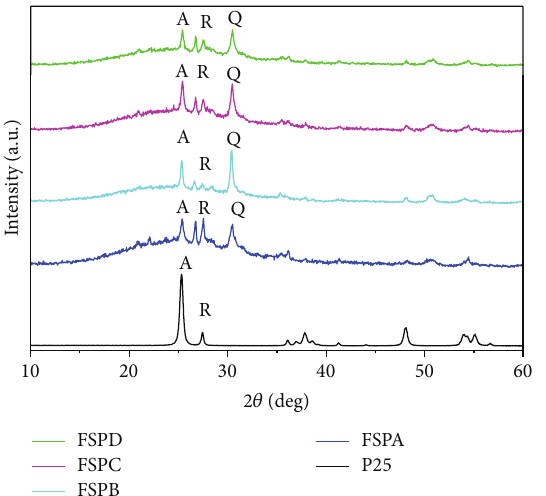
Figure 2: XRD patterns of TiO 2 /perlite correspond to the (101) reflection of the anatase and to the (110) of the rutile. For compari- son, the XRD pattern of Degussa P25 is presented.